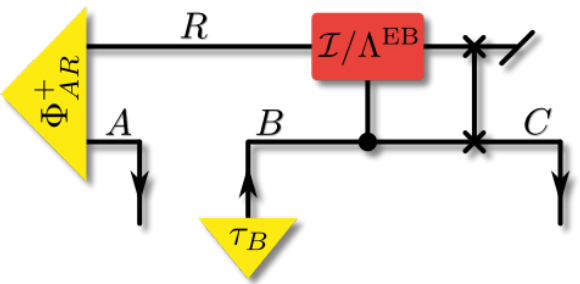
Figure 4: Bob controls the entanglement between Alice and Charlie. Controlled on Bob’s input, no transformation (i.e., I ) takes place on the environment line, or an entanglement breaking map Λ is performed. Afterwards, system and environment EB are swapped and the environment is